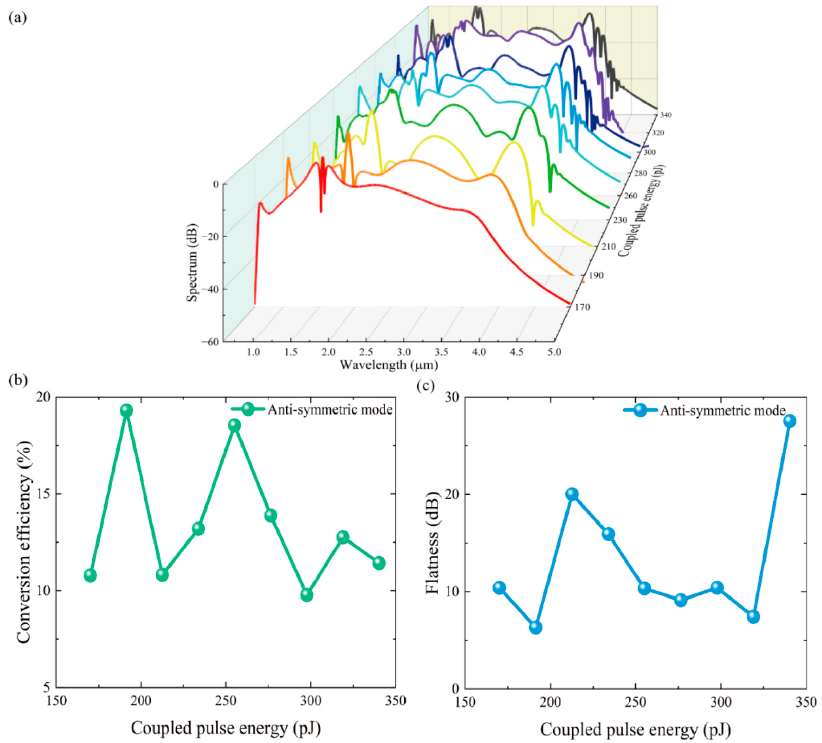
Figure 6. ( a ) The 3D waterfall of the output spectra at L = 0.95 mm with the full-width at half maxima τ FWHM = 75 fs at different coupled pulse energies. ( b ) The conversion efficiency as a function of the coupled pulse energy. ( c ) The flatness as a function of the coupled pulse energy.